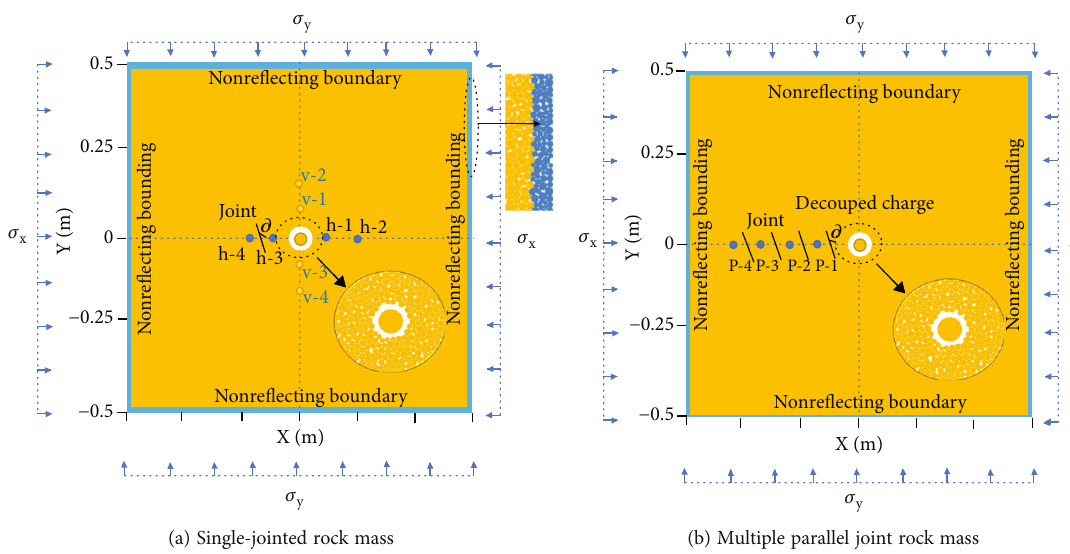
Figure 3: Numerical model for (a) a single-jointed rock mass at di ff erent inclination angle ∂ and (b) multiple parallel joint mass at di ff erent ∂ . The value of ∂ is changed to adjust the joint inclination angles to 0 ° , 25 ° , 50 ° , 75 ° , and 90 ° , but in the multiple parallel joint rock mass ∂ ≠ 0 ° .